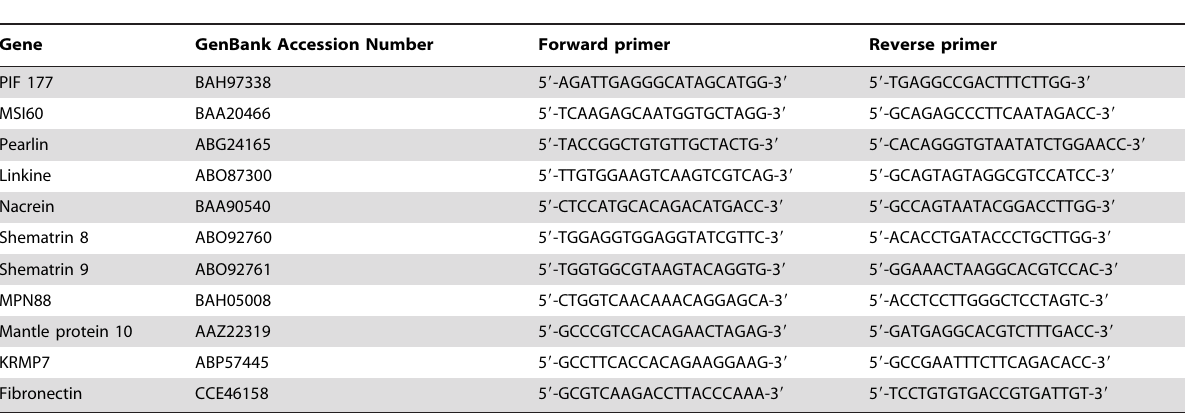
Table 1. Set of forward and reverse primers used for the gene expression analysis.